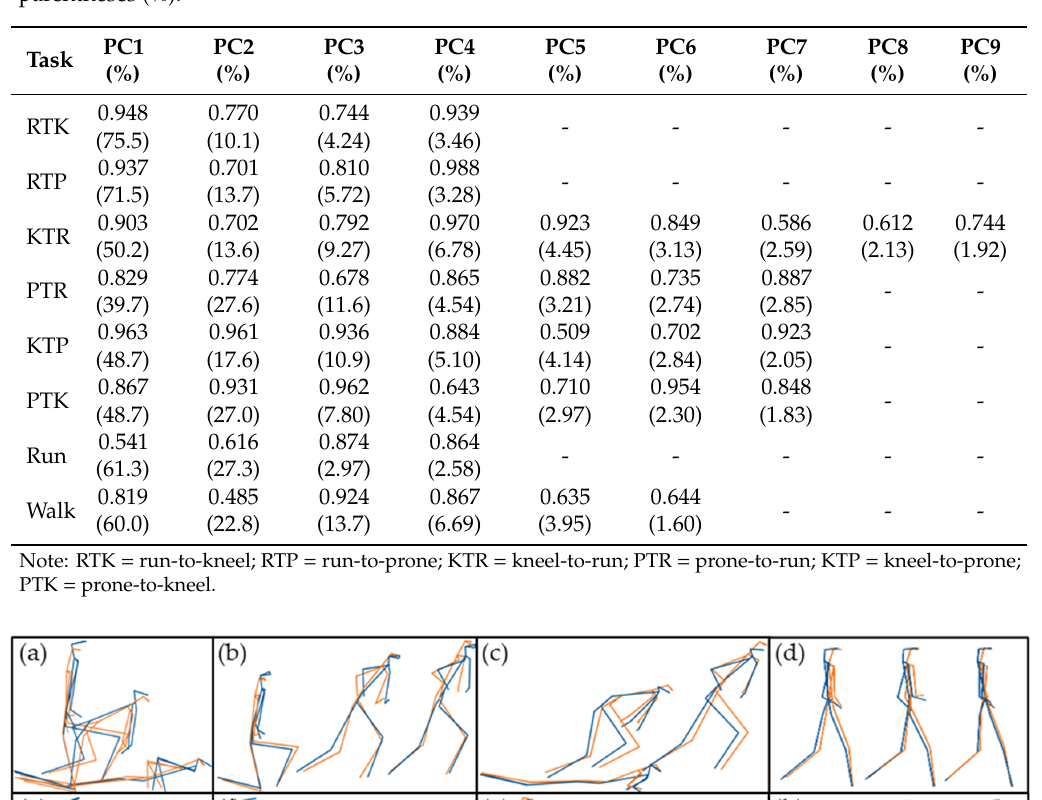
Table 2. Retained principal component (PC) correlation coe ffi cients. Explained variance is in parentheses (%).